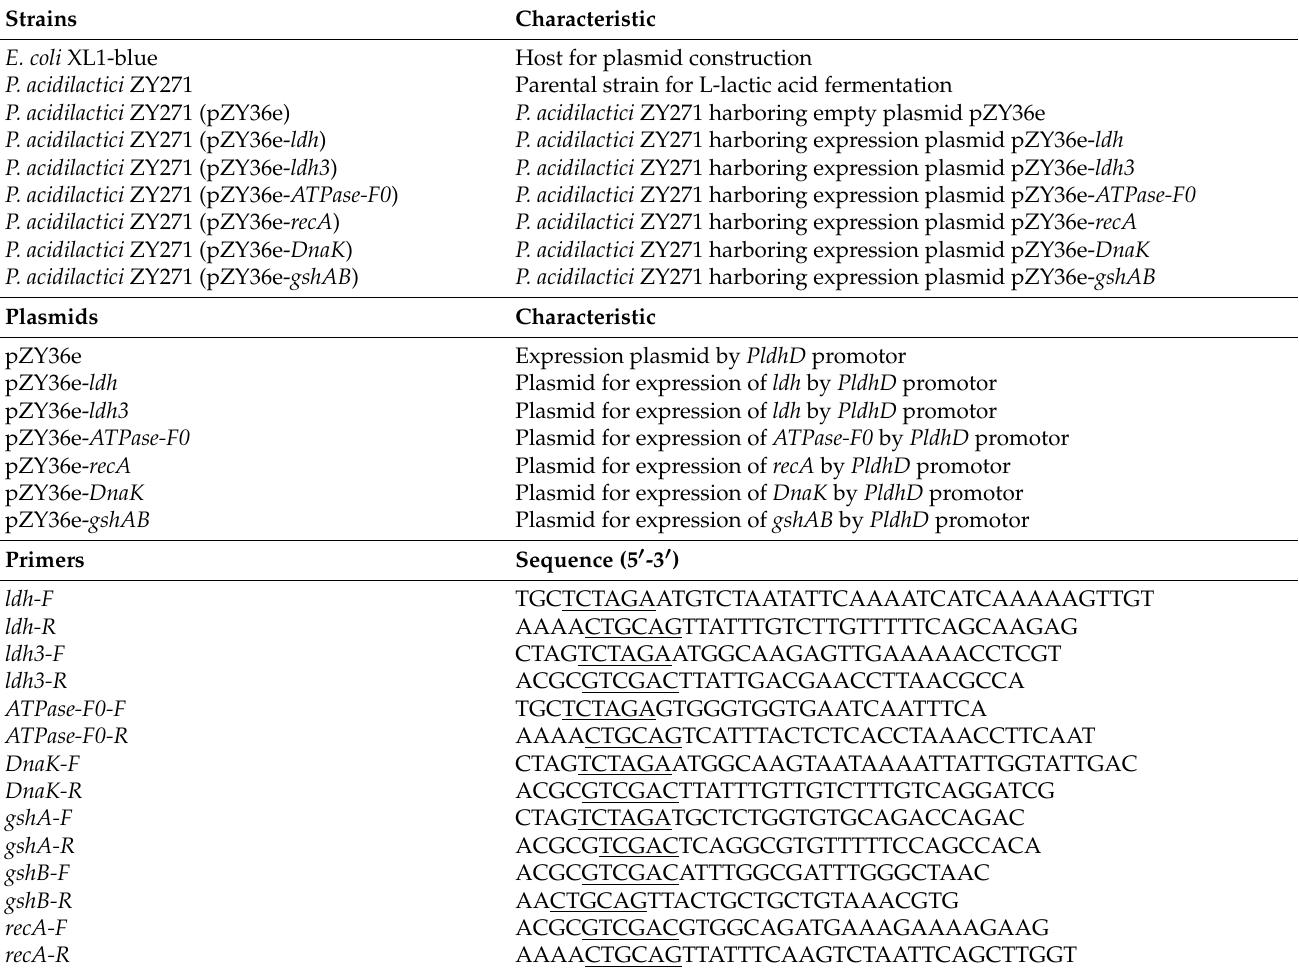
Table 1. Strains, plasmids, and primers used in this